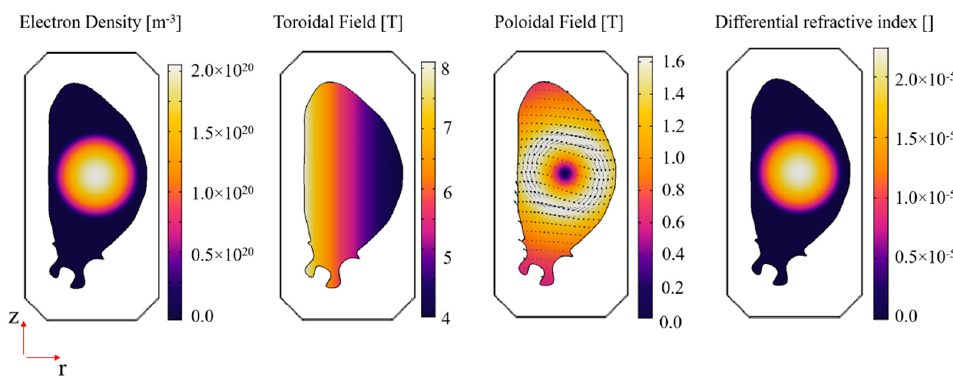
Figure 2. Property field of the plasma used for the numerical